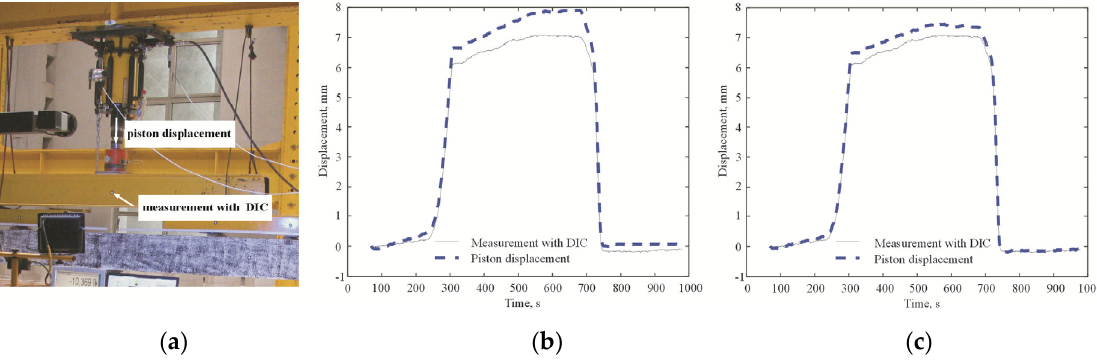
Figure 16. Comparison of results from structure measurements using the LVDT transducer and the DIC technique: ( a ) hydraulic actuators and steel cross beams were measured using the DIC technique, ( b ) actual results of displacements, ( c ) displacement results containing the correction factor.